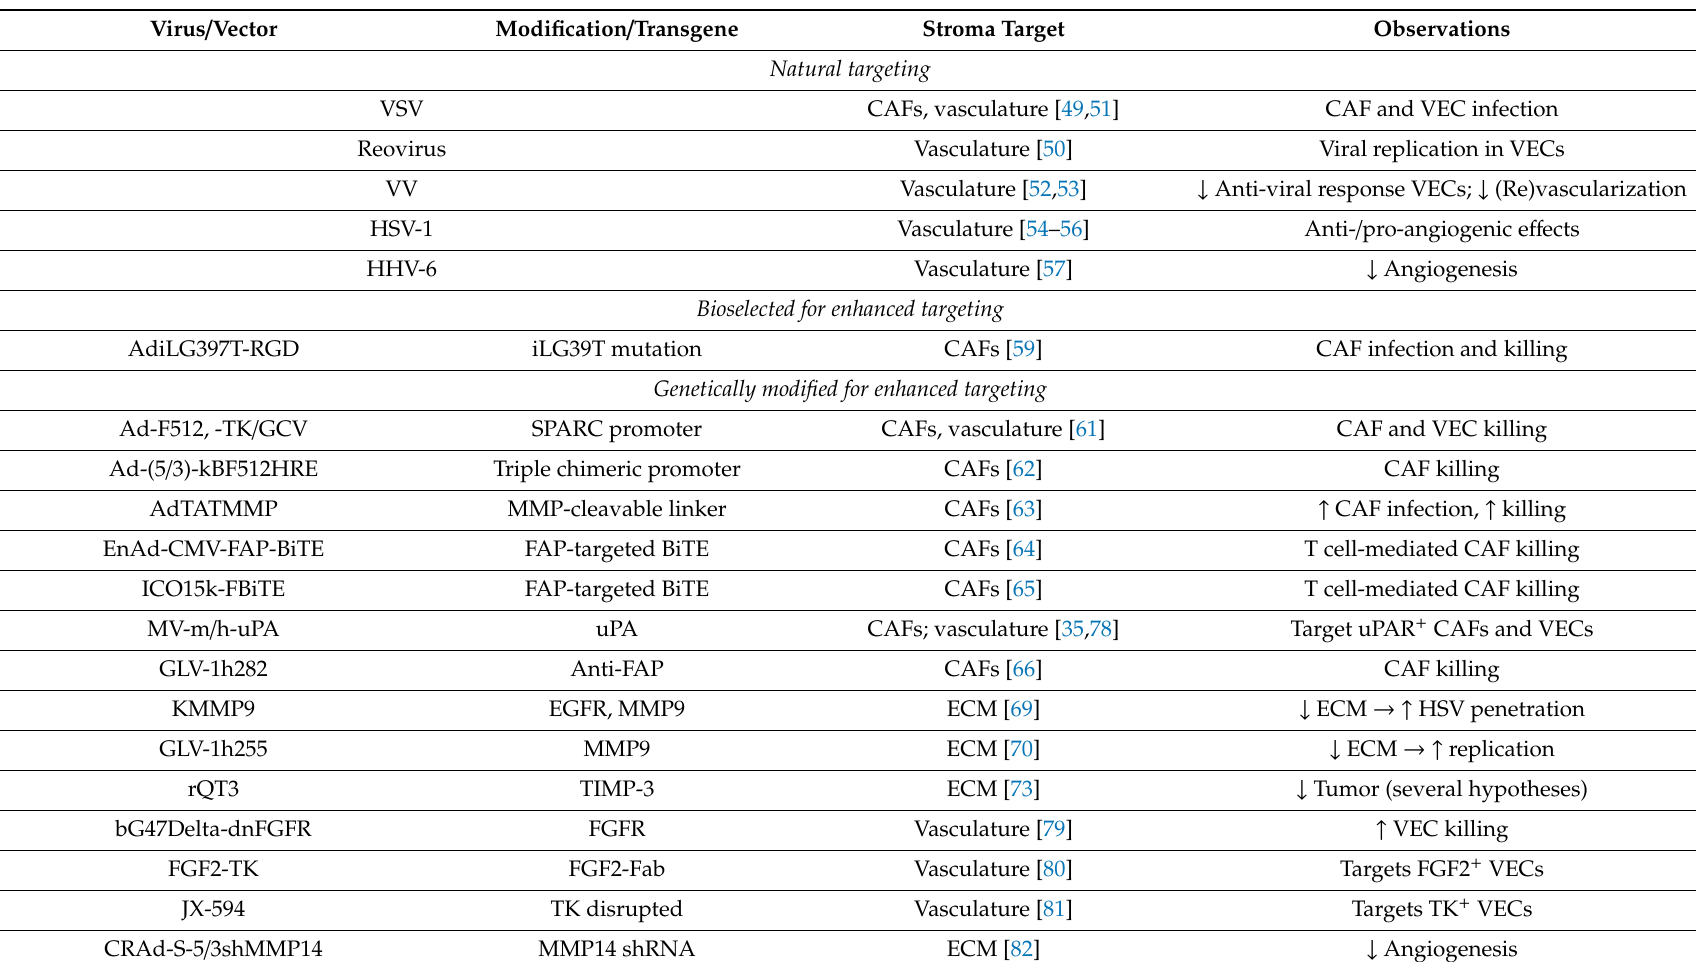
Table 2. Overview of inherent, bioselected and genetically engineered OVs targeting tumor stroma